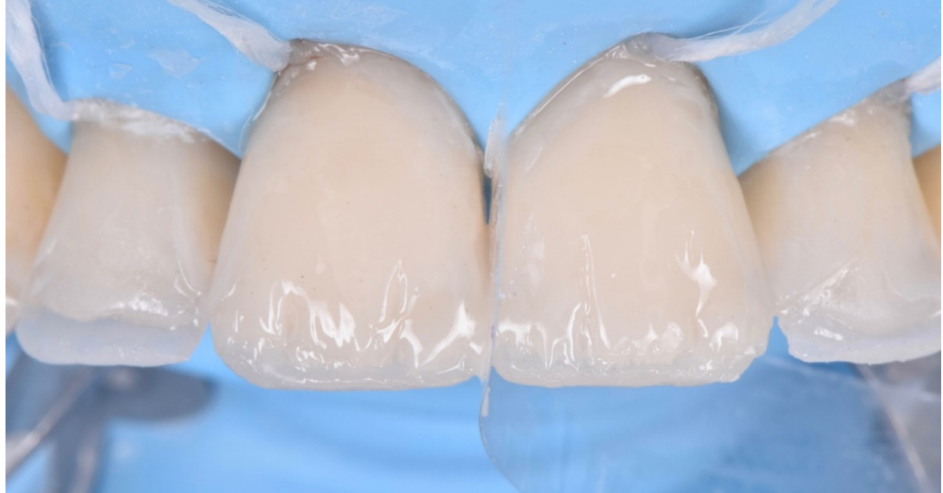
Figure 25. Dentin layer following the “natural layering concept”.